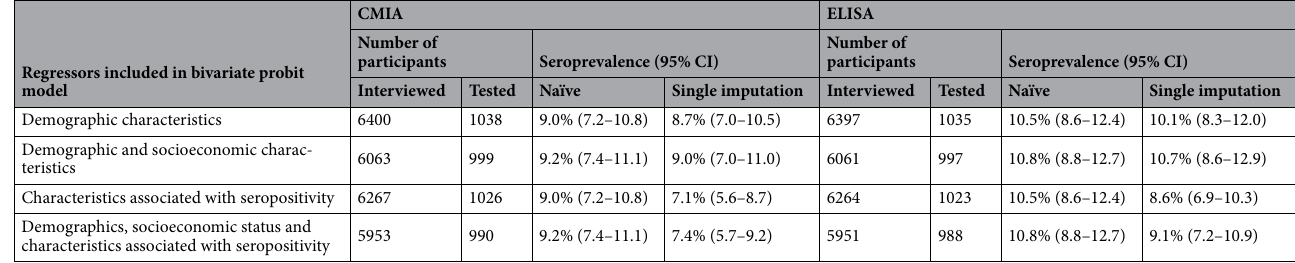
Table 1. SARS-CoV-2 seroprevalence estimates from bivariate probit models with different sets of individual characteristics for non-response correction. “Demographic characteristics” means the following variables: individual age group (18–34, 35–49, 50–64, 65+ years old) and sex. “Socioeconomic characteristics” means the following variables: higher education status and higher self-reported income level. ”Characteristics